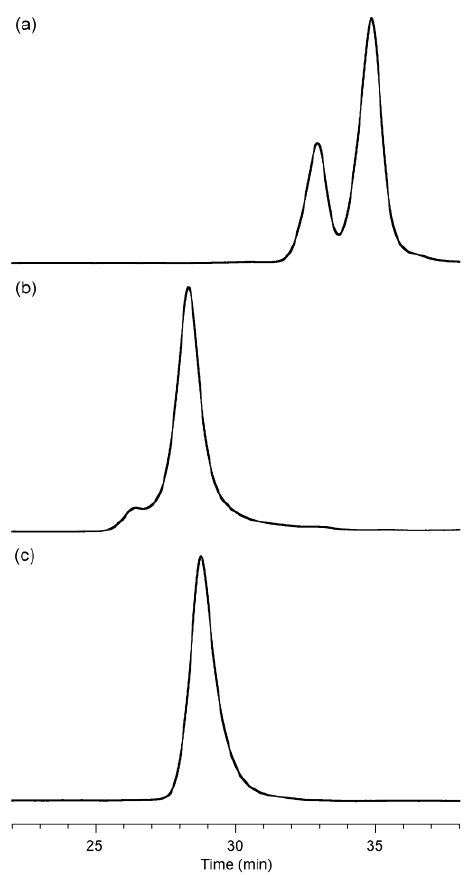
Figure 4. Analytical SEC traces (λ det = 550 nm) for the synthesis of a triad array 22 . ( a ): Mixture of starting materials 11 and 21 . ( b ): Crude mixture after reaction for 4 h. ( c ): Purified triad 22 .